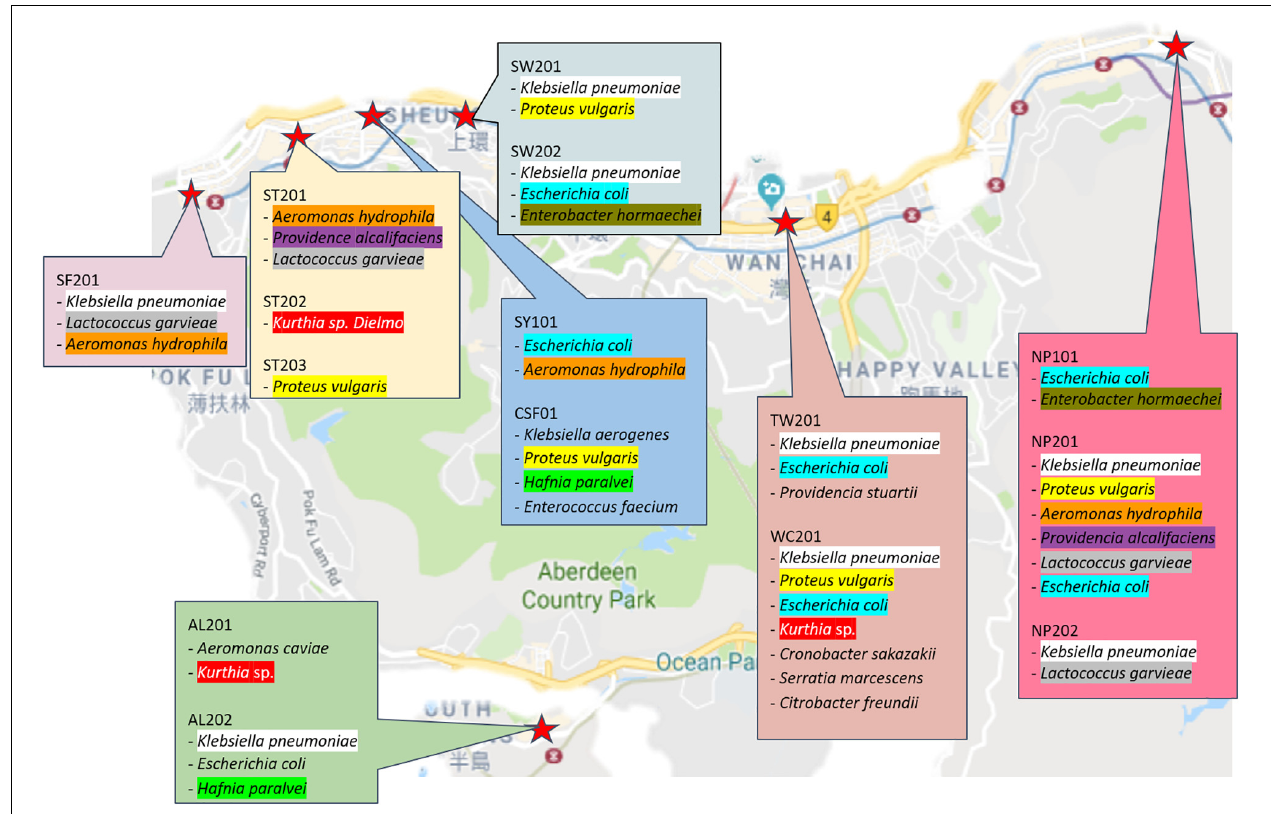
FIGURE 4 | Origin of isolated strains from previously sampled wet markets in Hong Kong Island. TABLE 2 | Isolates that tested positive for harboring antibiotic resistance gene(s). Sample